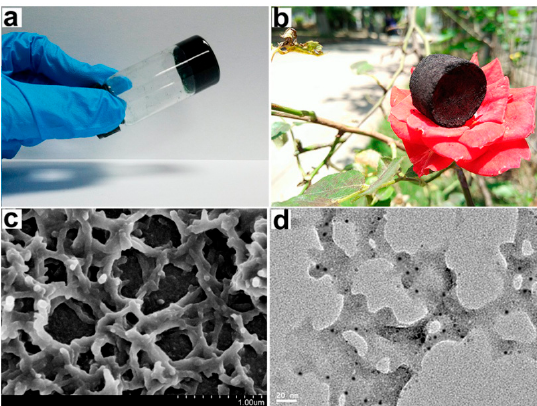
Figure 8. A nanocomposite hydrogel by Liang et al. shown in ( a ) had an extremely low density upon solvent removal, as seen by its aerogel balancing on a flower in ( b ), due to high porosity, as shown in micrographs ( c ) and ( d ). The porosity promotes ion transport and high capacitance [77]. Adapted with permission from ref [77]. Copyright 2015 John Wiley and Sons.